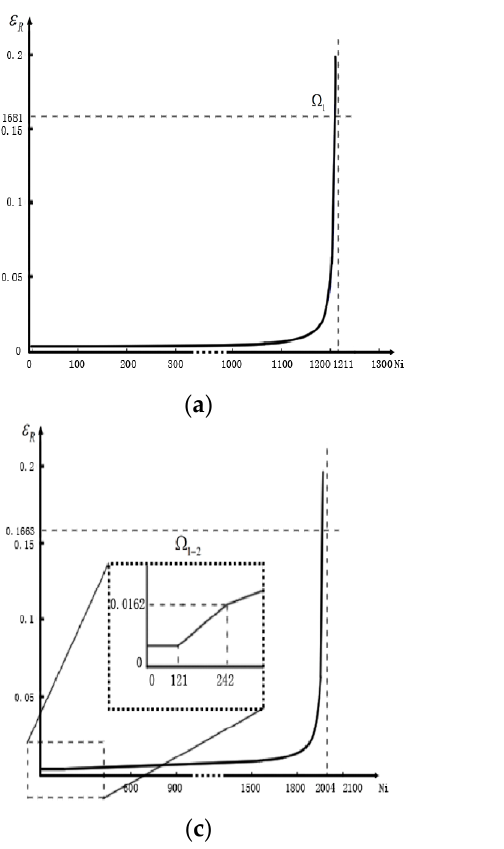
Figure 9. Resistance strain curve in certain thermal load conditions.